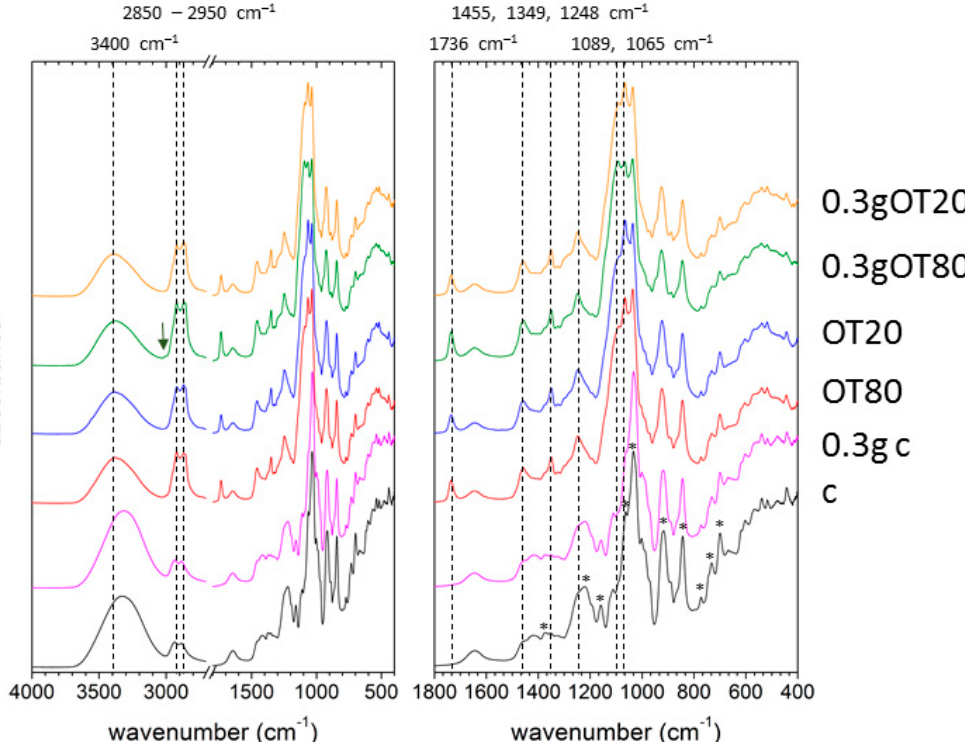
Figure 6. Attenuated total reflectance (ATR) Fourier-Transform spectroscopy (FTIR) spectra of the films prepared without the addition of trehalose.